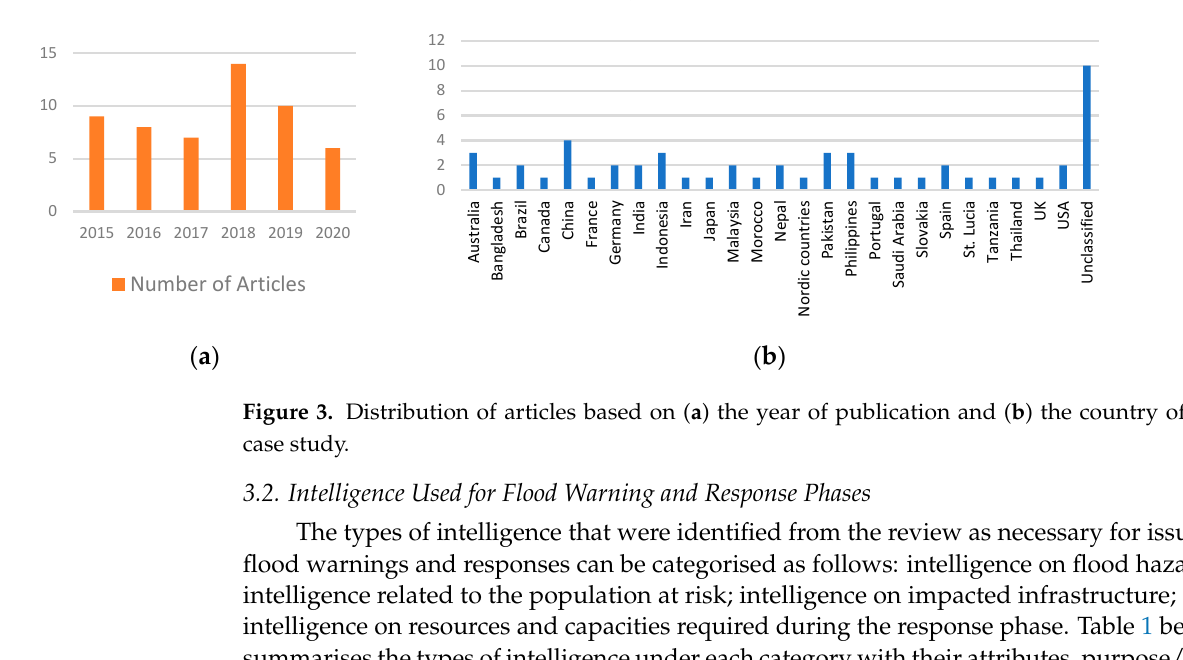
Figure 3. Distribution of articles based on ( a ) the year of publication and ( b ) the country of the case study.